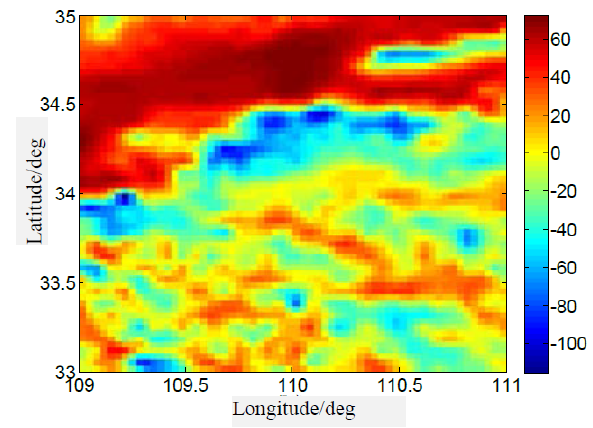
Fig. 4. stds of δg component difference between classical Stokes integral values and true values